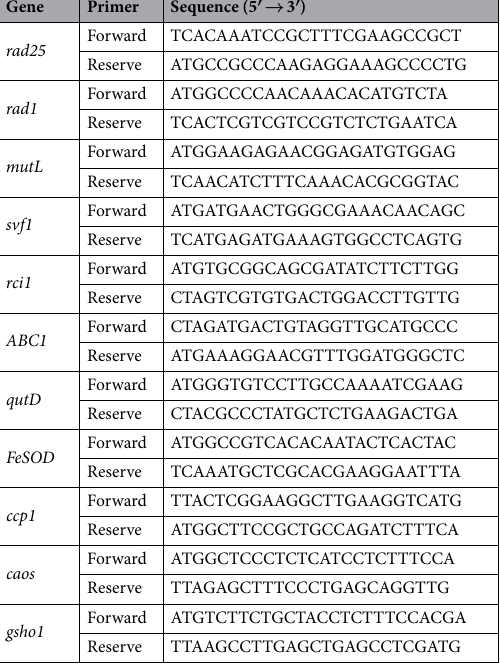
Table 4. qRT-PCR primers used in this